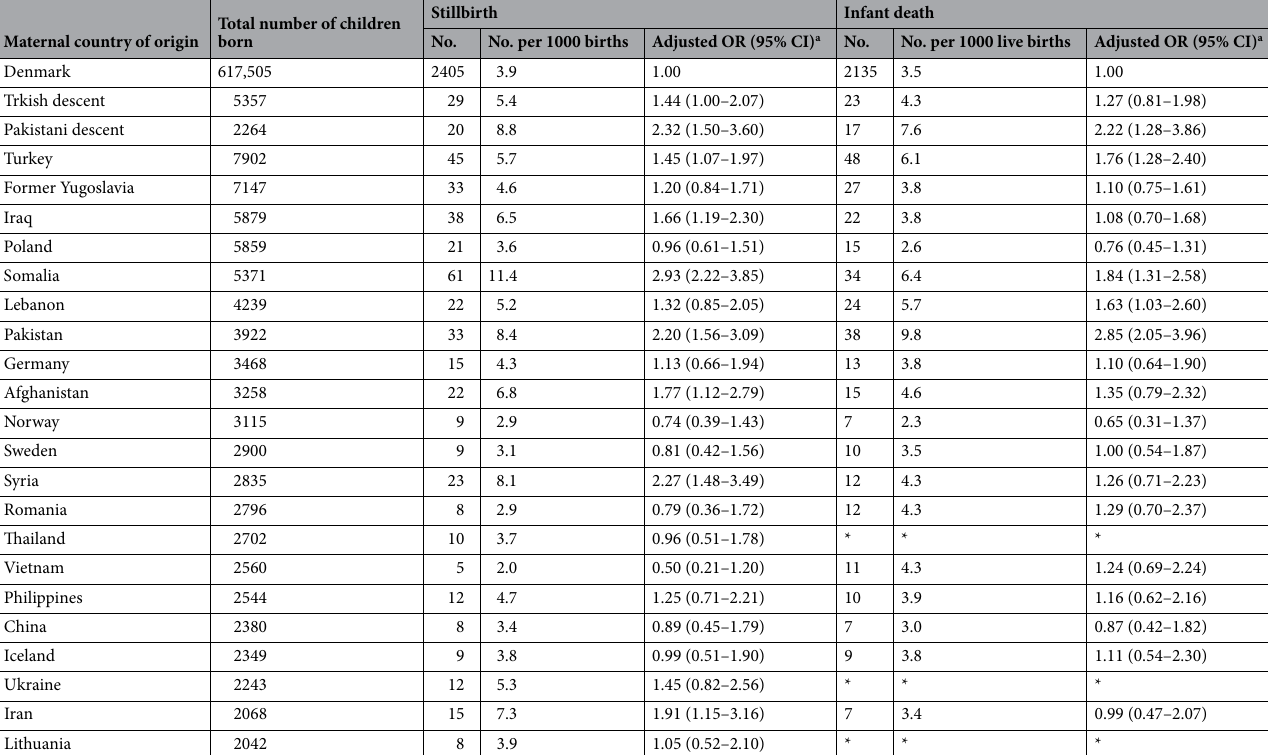
Table 2. Prevalences, absolute risks and odds ratios (OR) of stillbirth and infant death of children born in Denmark 2005–2016 by maternal country of origin. a Adjusted for year of birth. *Data not shown due to few observations. **Include all births to women of Danish origin and to subgroups of immigrants and descendants of immigrants with more than in total 2000 births from